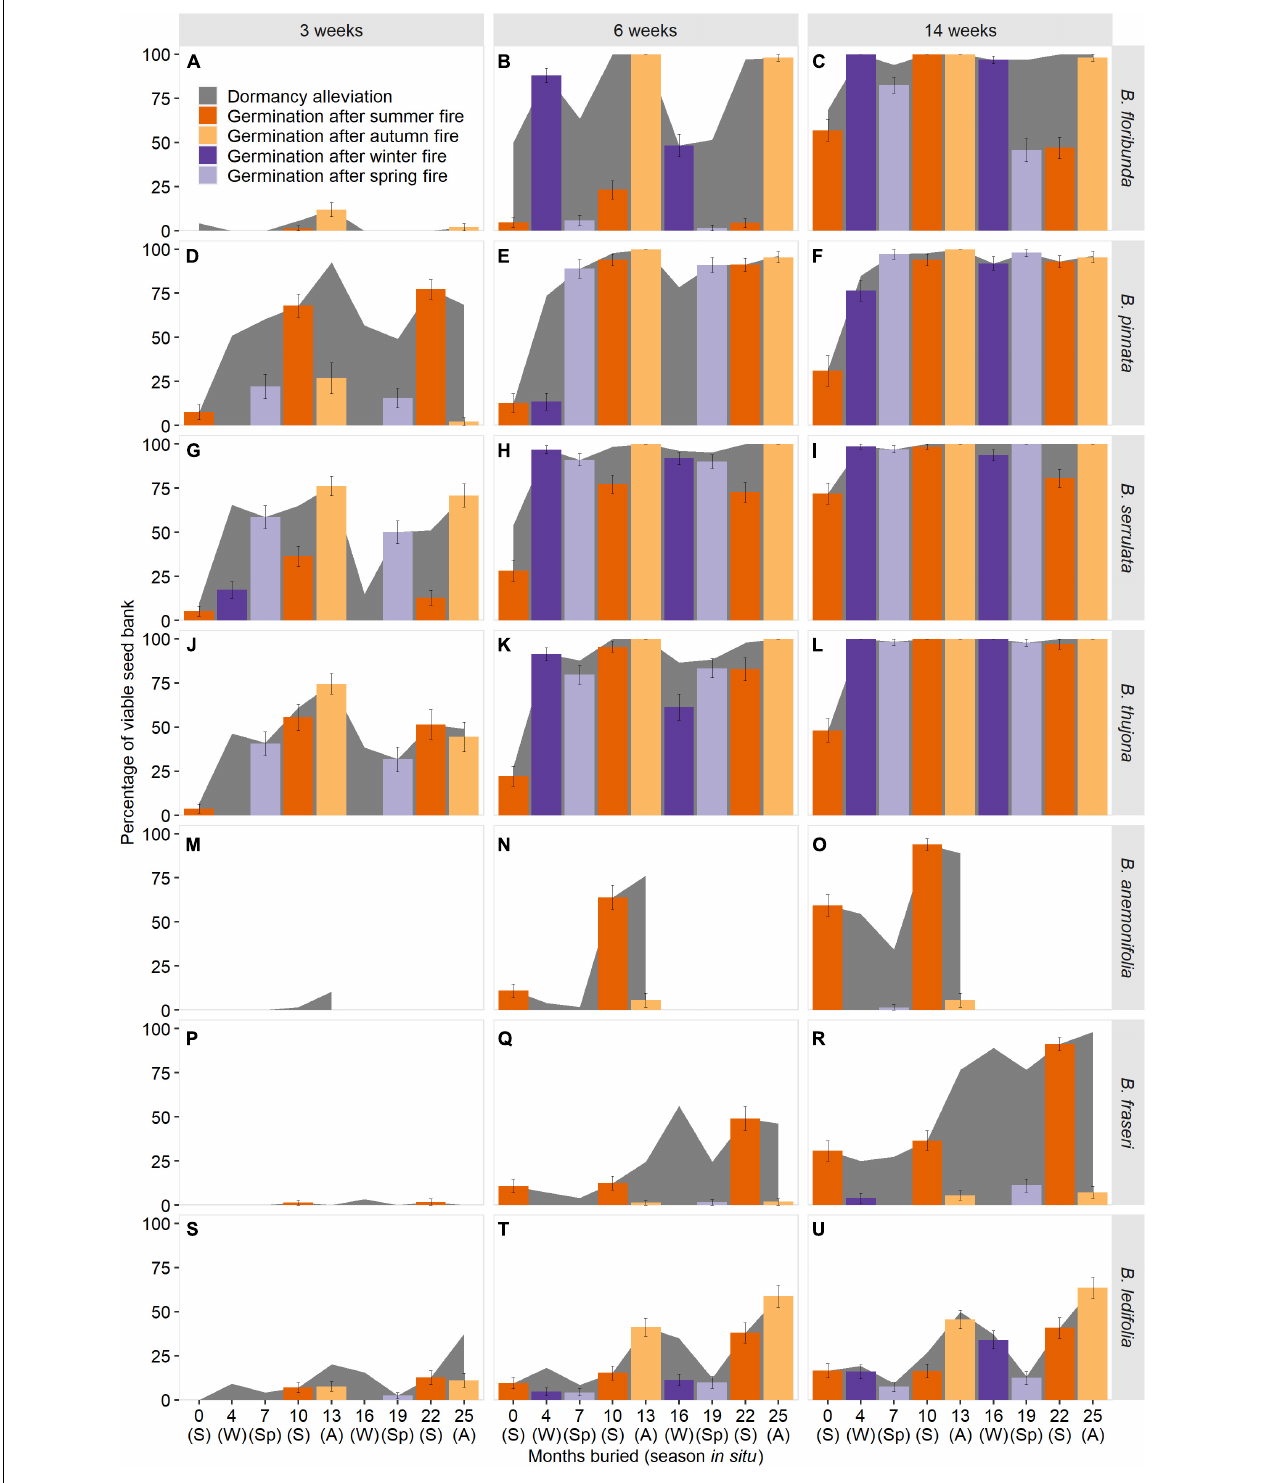
FIGURE 5 | Predicted germination in response to fires in different seasons for seven species of Boronia (Rutaceae) from south-eastern Australia as function of incubation period. S, summer; A, autumn; W, winter; Sp, spring. Background shading indicates the proportion of the viable seed bank in a non-dormant or conditionally dormant state and able to respond to combinations of seasonal temperatures and fire-related germination cues. Species are arranged by sections within the genus: Boronia (A–L) ; Cyanothamnus (M–O) ; and Valvatae (P–U) . Boronia anemonifolia was studied for 1 year only due to limited seed availability. Dormancy estimates for B. fraseri and B. ledifolia at 13 months have been imputed (refer to Supplementary Material 2 for details).